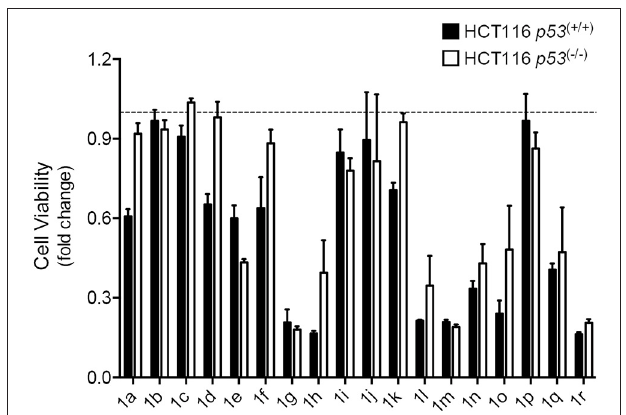
FIGURE 2 | Spiropyrazolines oxindoles screen in HCT116 human colorectal carcinoma cells. HCT116 p53 ( + / + ) and HCT116 p53 ( − / − ) cells were exposed to spiropyrazoline oxindoles 1a–r or vehicle (DMSO) at 12.5 µ M for 72h. Cell metabolism was evaluated by MTS assay. Results are expressed as mean ± SEM fold-change to vehicle treated cells from one experiment performed in duplicates. Dashed line represents vehicle control results.